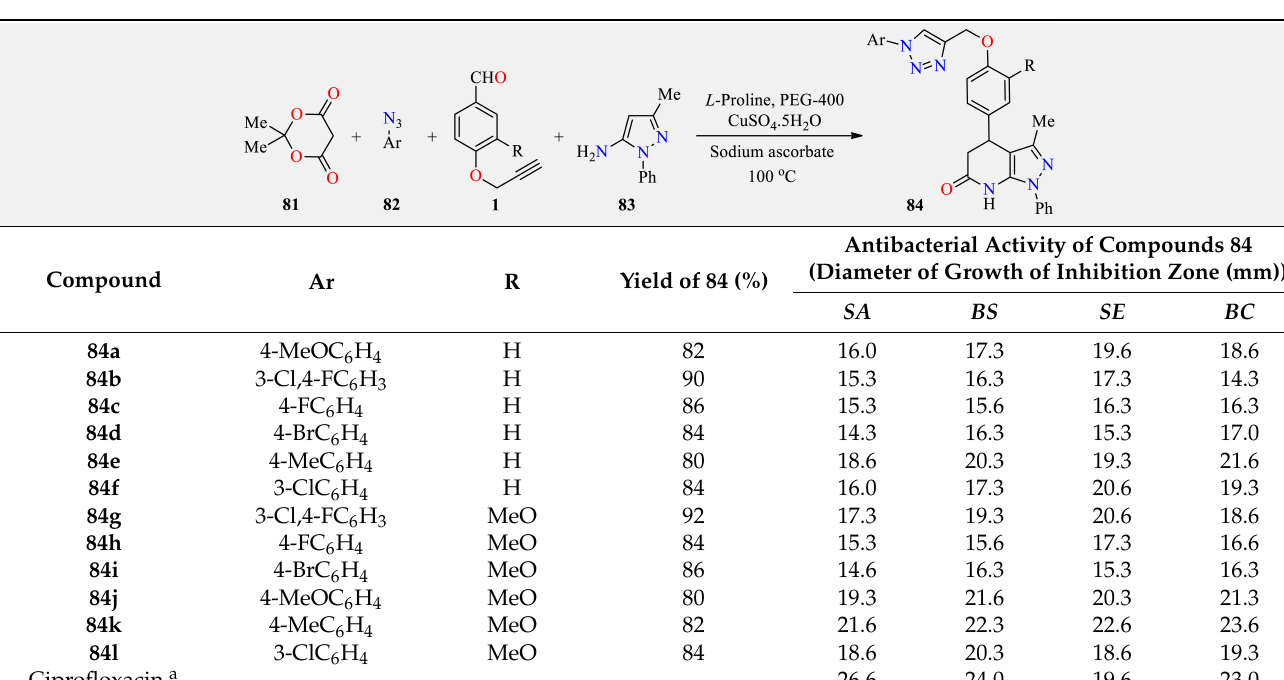
Table 20. Table 20. Four-component synthesis of 1 H -1,2,3-triazole-tethered pyrazolo[3,4- b ]pyridin-6(7 H )-ones 84 and their in vitro antibacterial activity against four bacterial